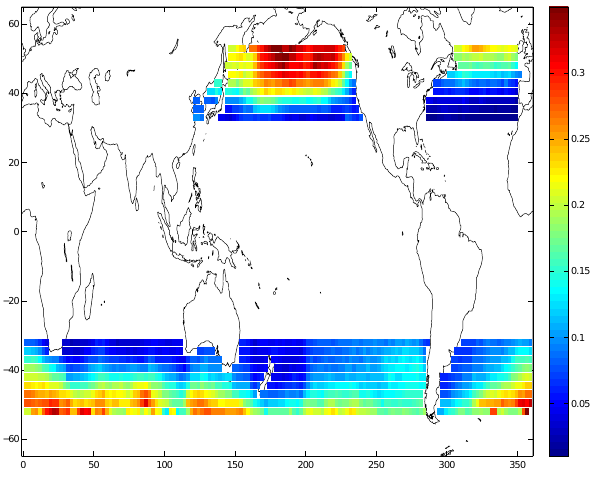
Fig. 12. As in Fig. 11, except for Cluster 5